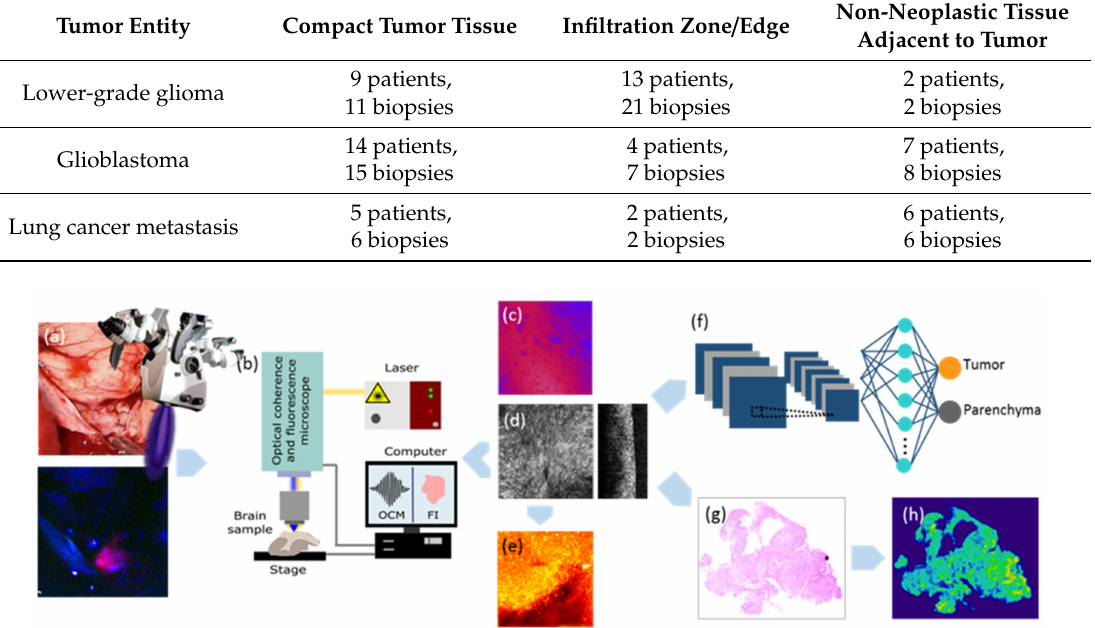
Figure 6. Workflow for the processing of CNS tumor biopsies. The samples were resected during 5-ALA FGS [13] ( a ) and immediately transferred to the lab, where FI-OCM imaging was performed ( b ). FI data were acquired before bleaching occurred ( c ), followed by OCM imaging ( d ). Based on OCM intensity data, attenuation maps were computed ( e ). Data post-processing was performed and all OCM data sets were evaluated using a convolutional neural classifier model ( f ). Subsequently, the samples were fixed in 4% formalin and processed for histopathological workup. H&E staining ( g ) and cell density maps ( h ) served as ground